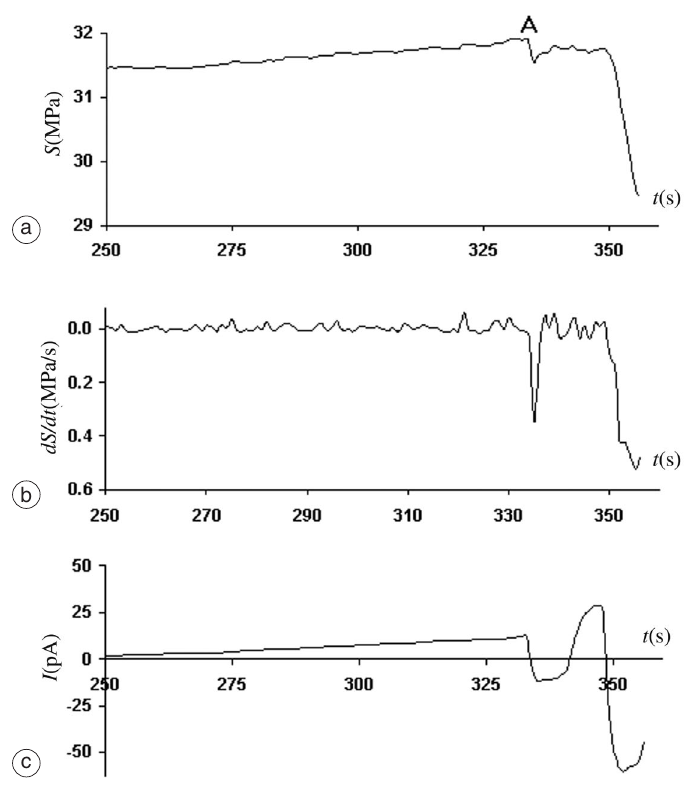
Fig. 6a-c. Time records of two PSC peaks taken from a marble sample (MD014) at fracture: a) curves, b) de- pict stress and (c) stress rate